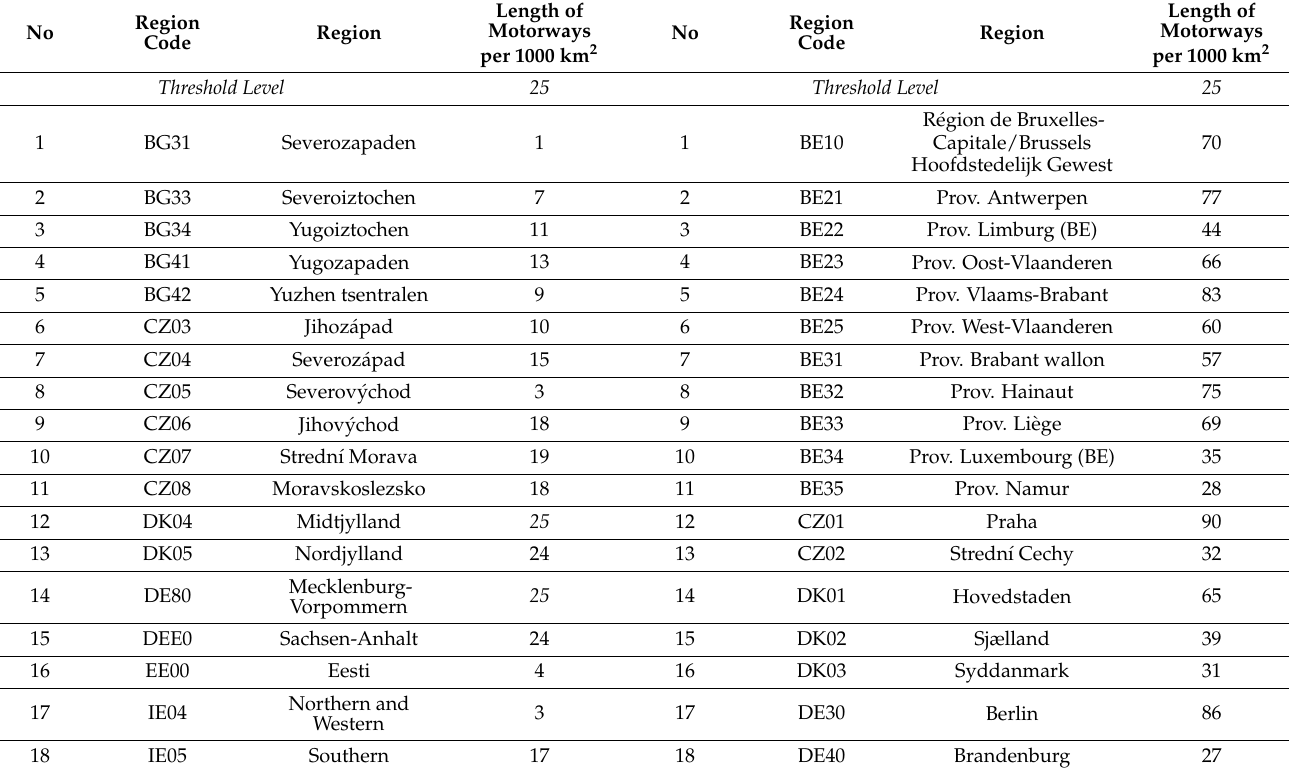
Table A3. EU regions divided into groups according to whether they exceeded or not motorways development threshold